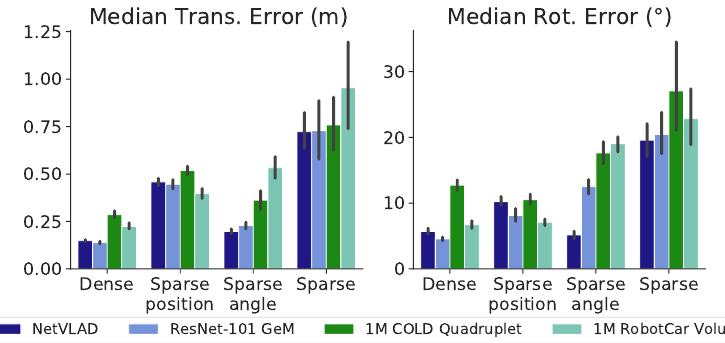
Figure 7. Median tracking errors of our proposal for the test sequences on the SUNCG generated maps, with 10 3